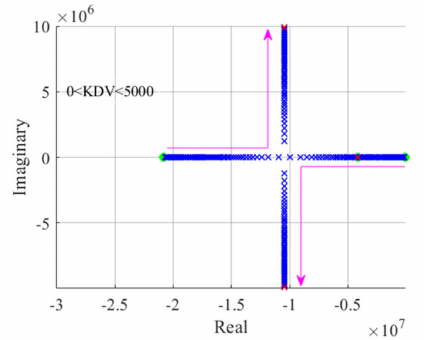
Figure 9. The TL VSI eigenvalues.